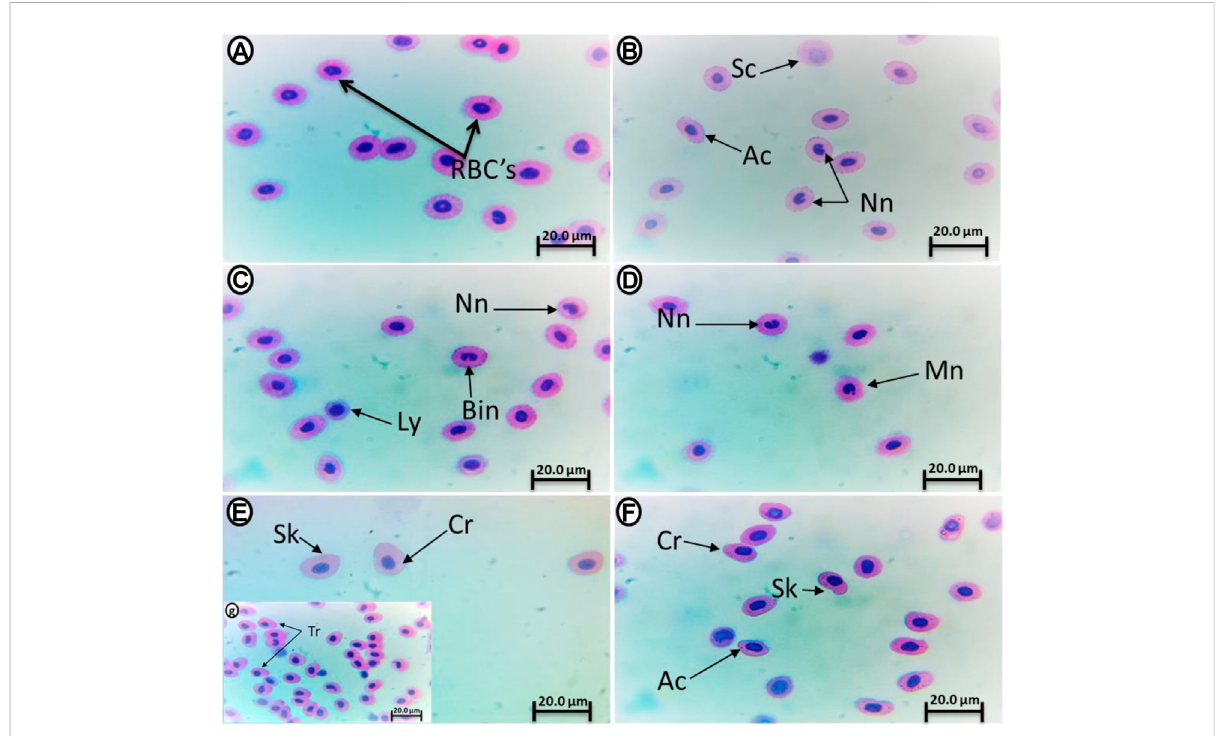
FIGURE 5 Represented blood smears from juvenile Tilapia , Oreochromis niloticus . (A) Control; (B – F) exposed to 100 μ g/L alkaline rocks samples for 15 days; (RBCs) red blood cells; (Ac) acanthocytes (Cr) crenated cells; (Sk) Sickle cells; (Tr) teardrop--like cells; (Shc) Schistocyte; (Amc) Amoeboid cells, H and E stain, scale bar: 20 μ